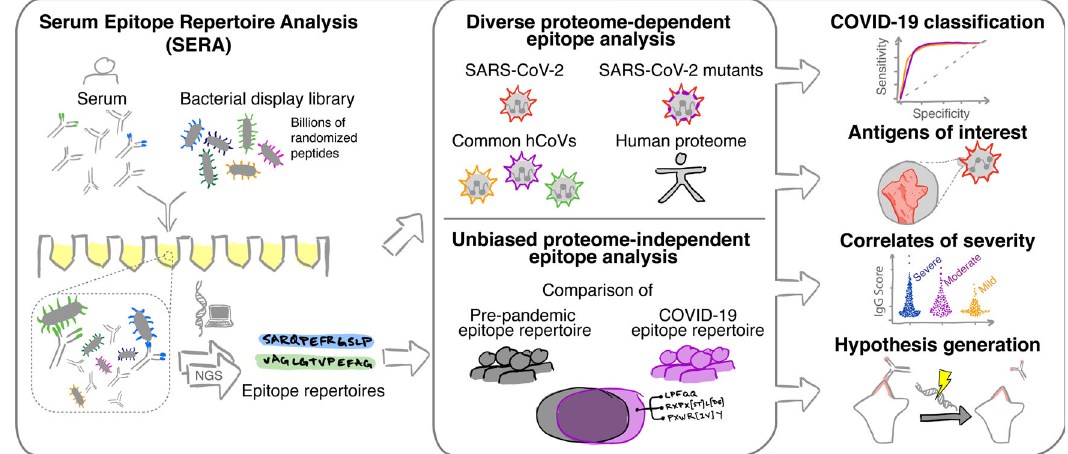
Fig. 1 The Serum Epitope Repertoire Analysis (SERA) platform enables high-resolution mapping of SARS-CoV-2 antibody repertoires. The SERA assay results in a set of ~1 million unique peptides, the “ epitope repertoire ” , for each individual. Repertoires were deposited in a database and compared with pre- pandemic controls to identify conserved epitopes in SARS-CoV-2 using proteome-dependent and -independent bioinformatic methods. SERA enables analysis of COVID-19 repertoires against any proteome including mutant SARS-CoV-2 strains, human common coronaviruses and the human proteome for discovery of potential autoantigens. The identi fi ed epitope signatures can be used to build diagnostic classi fi ers, to identify correlates of disease severity, and to develop hypotheses based on cases with speci fi c symptoms and/or disease course (neurological, GI, cardio